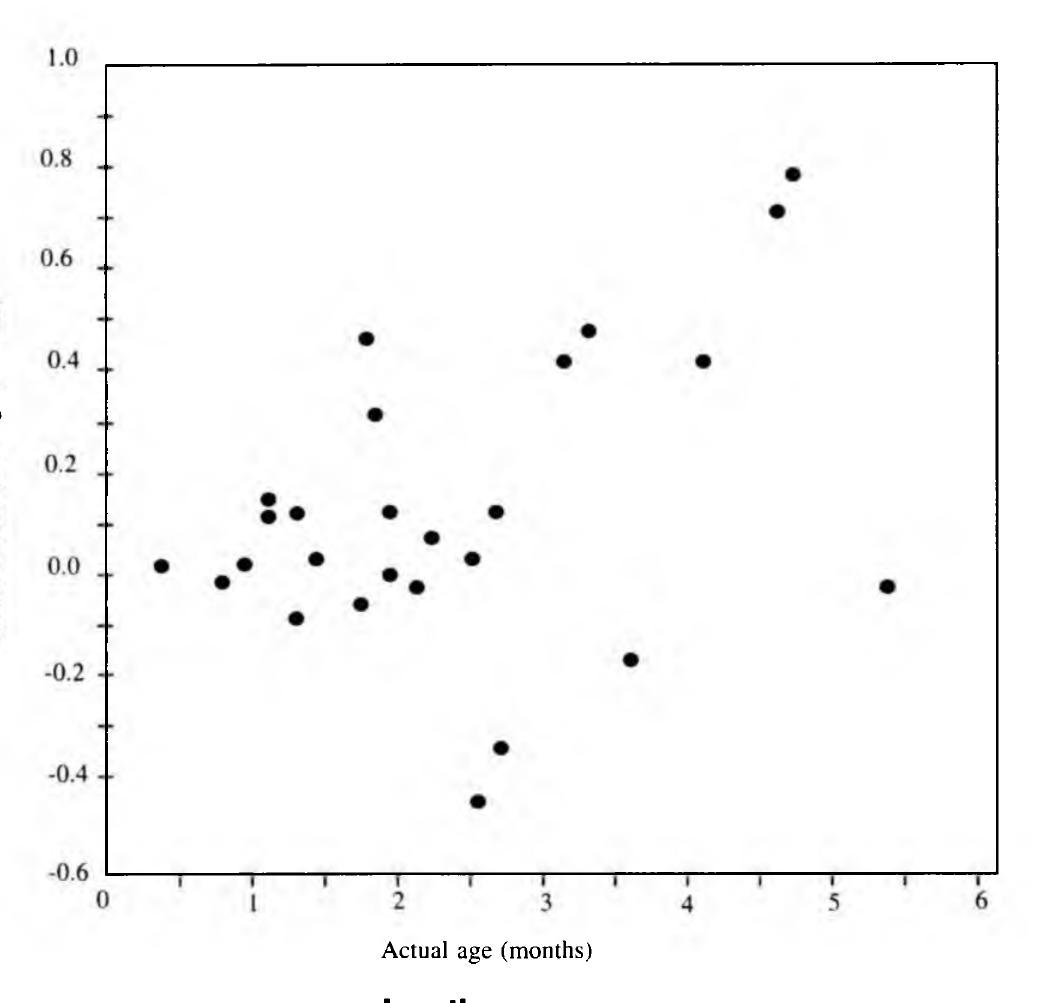
Figure 4 Error in the estimation of